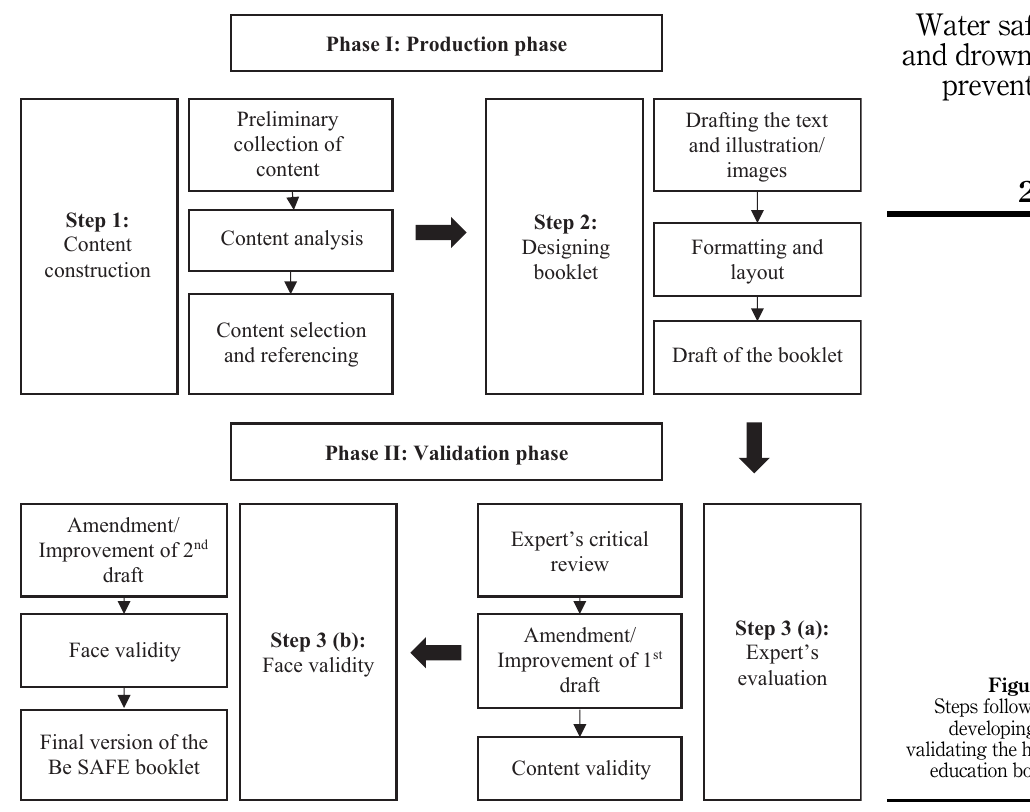
Figure 1. Steps followed